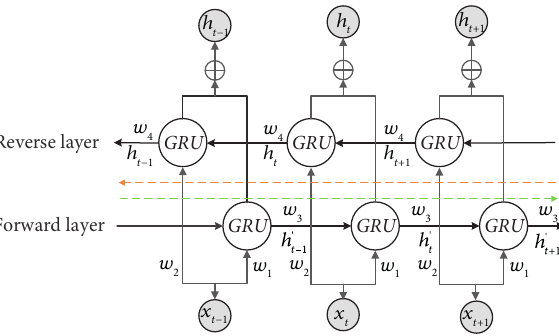
Figure 1: Bi-GRU network structure